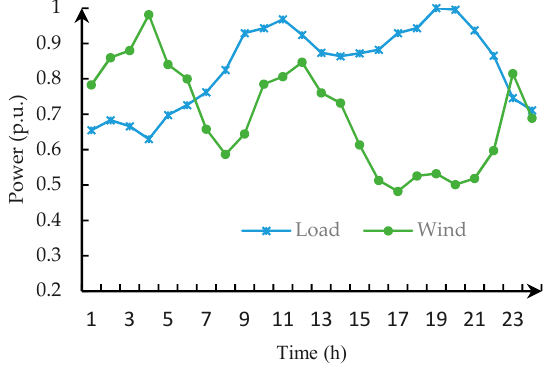
Figure 2. Load and wind power scenarios. Table 1. Relevant parameters of energy storage and interruptible load.